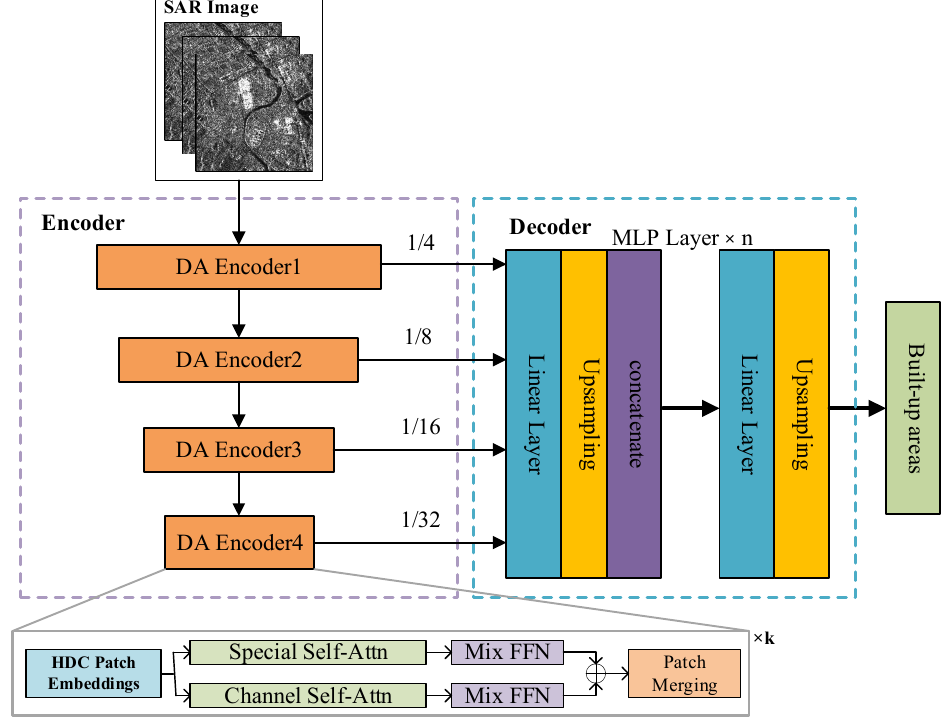
Figure 3. The architecture of the proposed model.